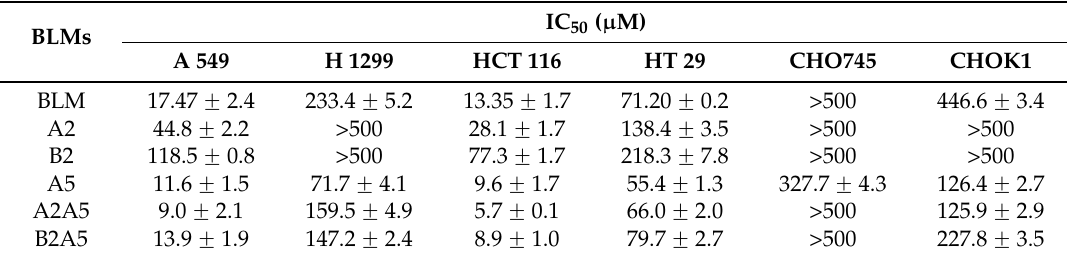
Table 1. IC 50 values of the BLMs in six different cell